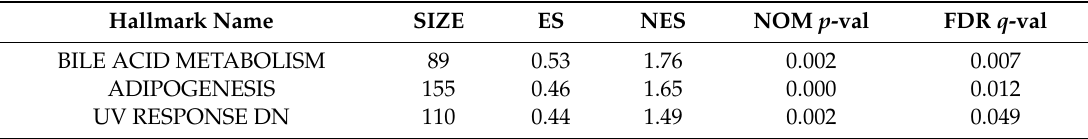
Table 4. Hallmark gene sets enriched in post-NACT